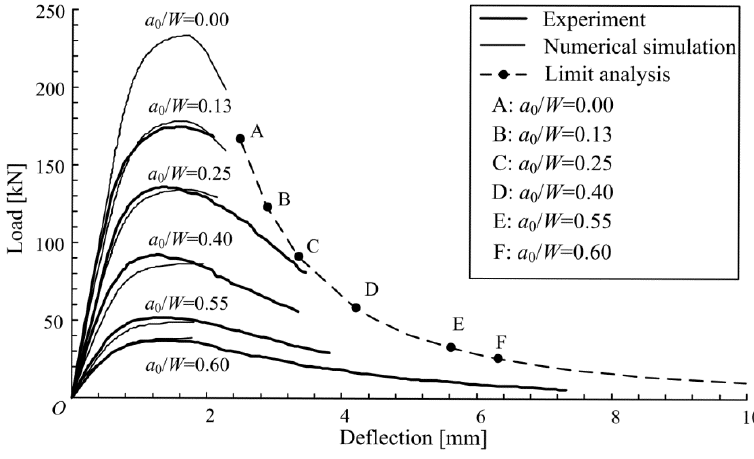
Figure 12. Comparison between numerical simulations and experimental results [24] for TPB tests with different initial crack lengths (the points A, B, C, D, E, and F represent the lower bound of limit analysis for different initial crack